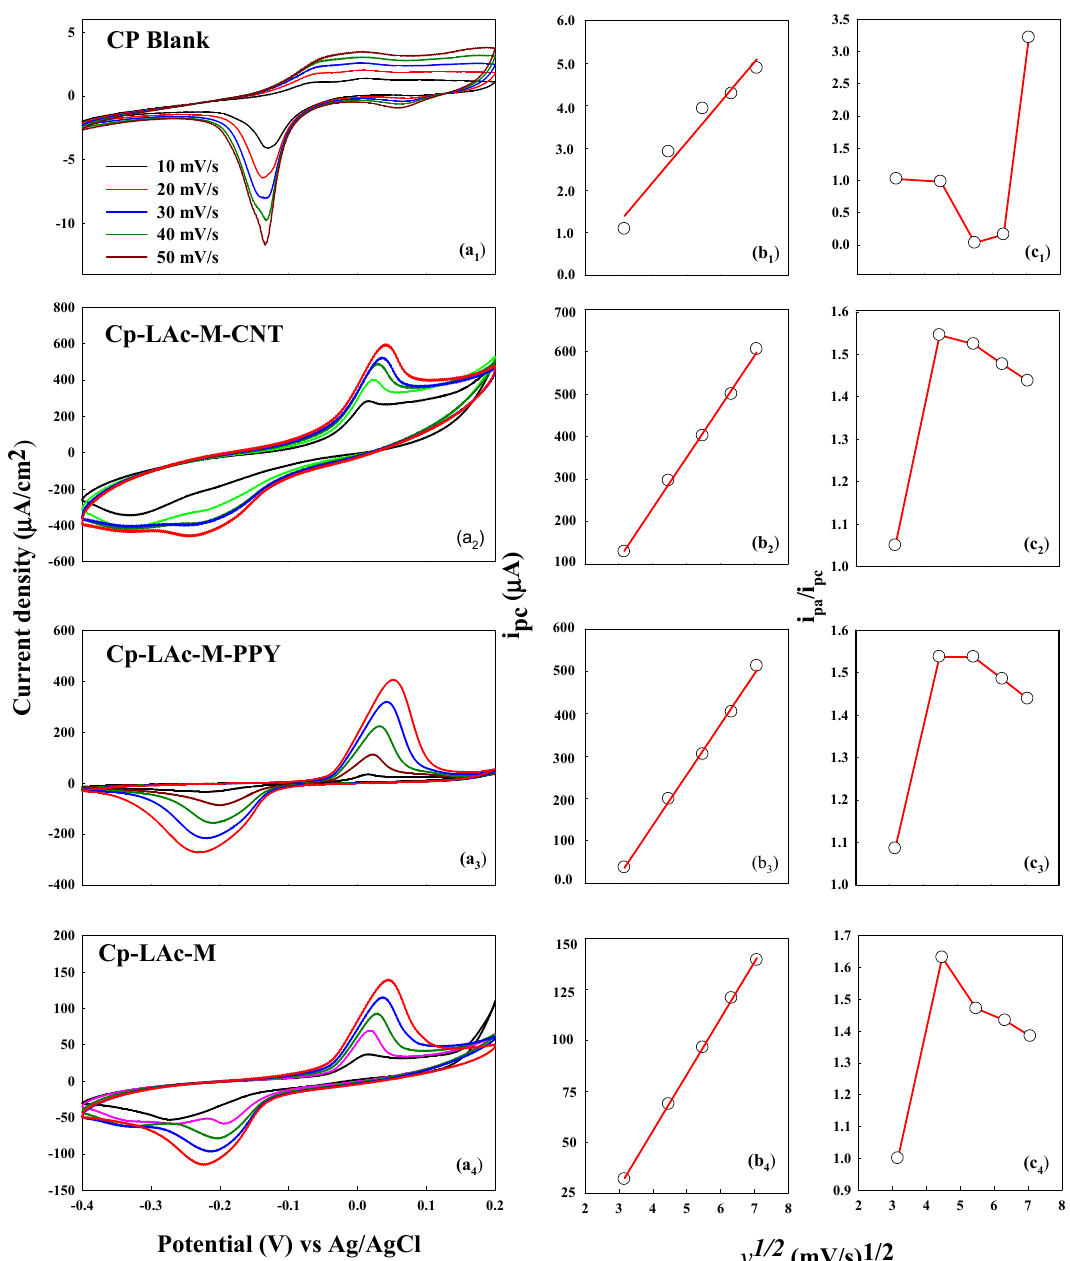
Figure 2. ( a 1 – a 4 ) Cyclic voltammogram for the blank electrode and biocathode electrode with different combinations at different scan rates 10–50 mV/s, ( b 1 – b 4 ) i pa in proportionality to the square root of the scan rates, and ( c 1 – c 4 ) ratio of i pa :i pc to the square root of the scan rates.